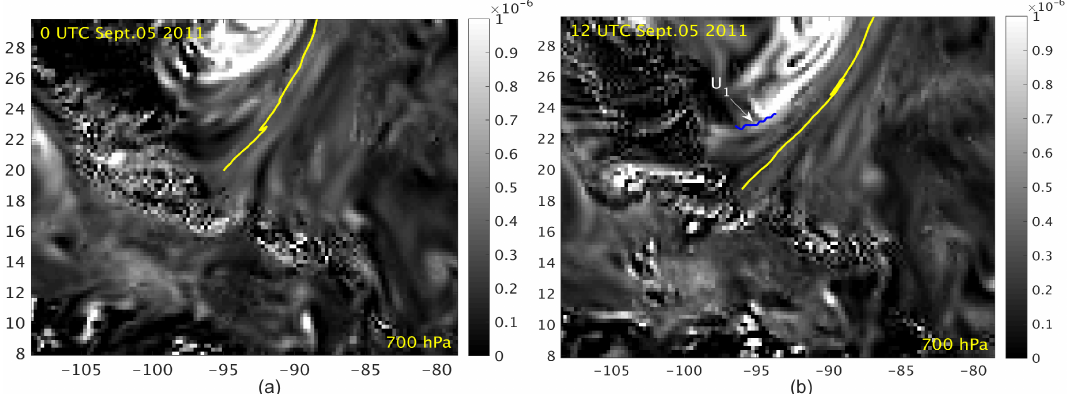
Figure 2. The unstable (yellow, blue) manifolds are overlaid on the ECMWF potential vorticity (PV) field (Km 2 kg − 1 s − 1 ) at 700hPa (a, b) at 00:00UTC on 5 September and 12:00UTC on 5